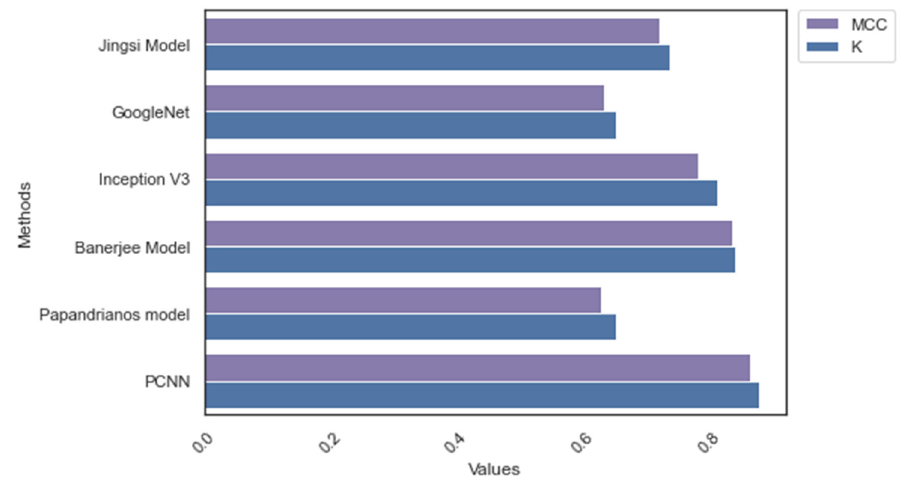
Figure 11. MCC and Kappa: Dataset_2. Table 9 outlines the memory size and computing time during the training phase.